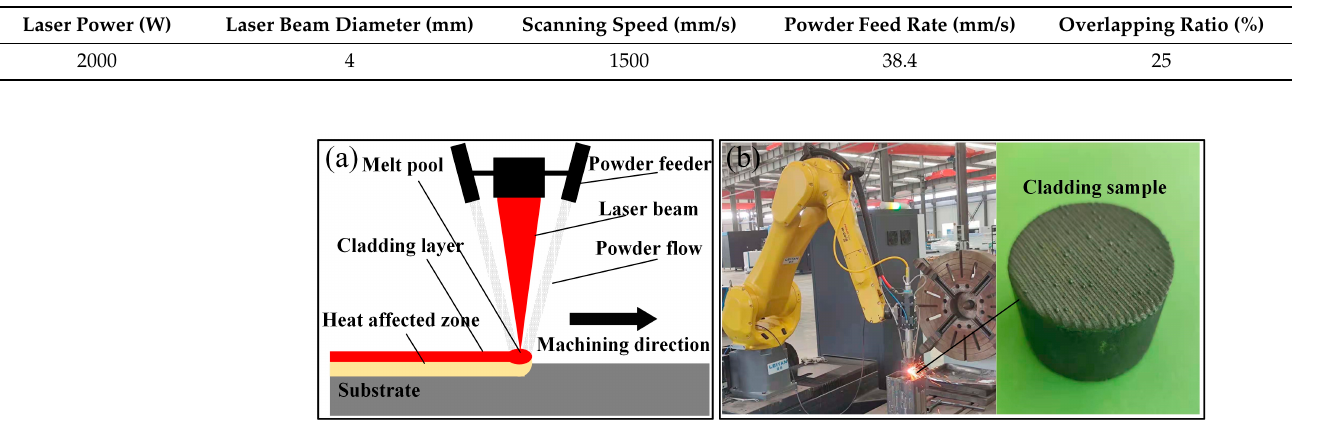
Figure 2. ( a ) Processing of laser cladding, ( b ) photos of laser cladding.